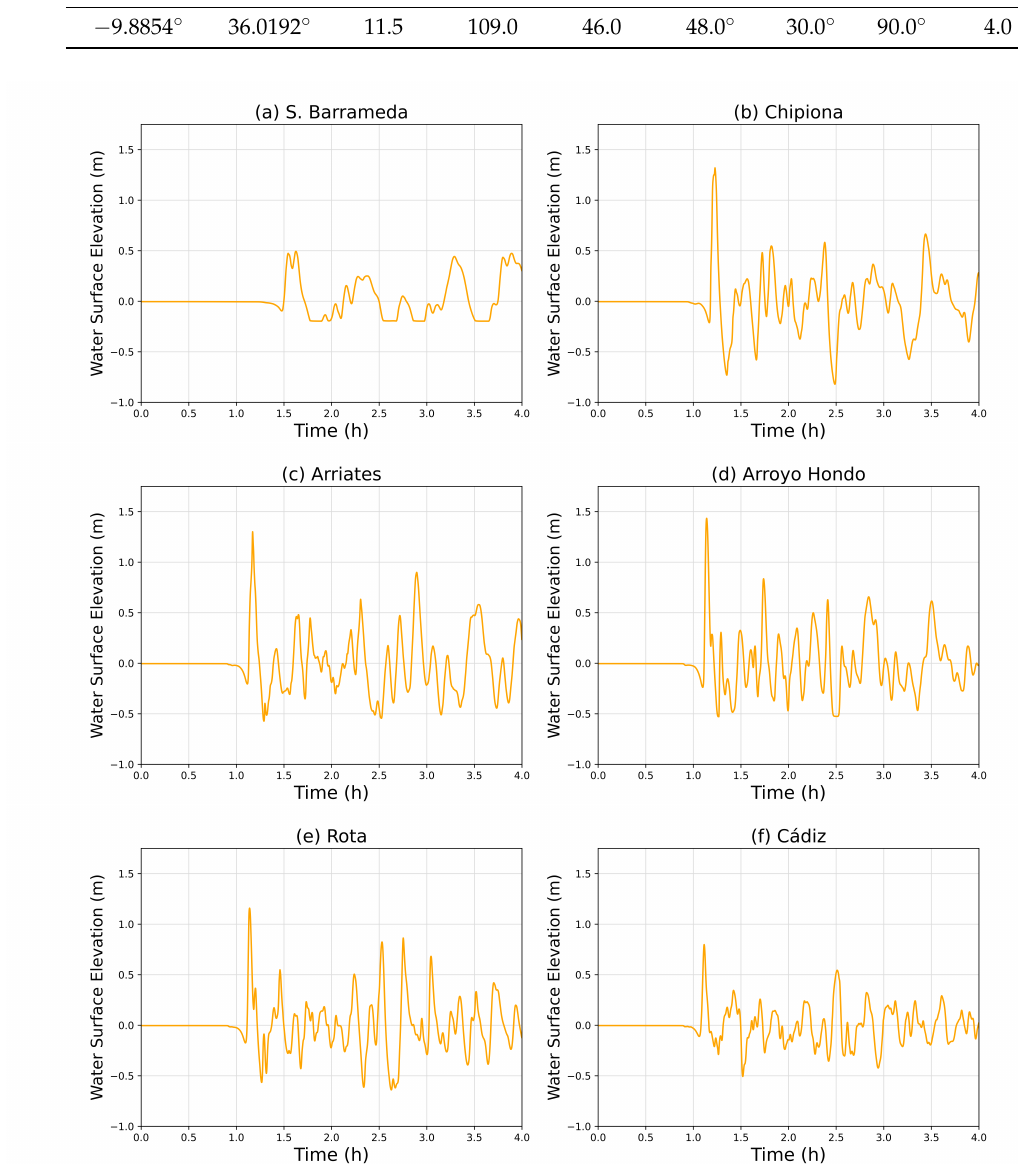
Figure 3. Time series for the sea surface elevation at the six forecast points for the reference